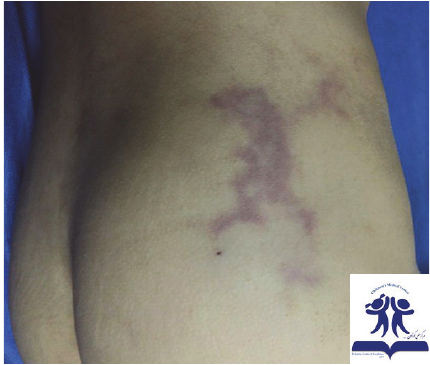
Figure 3: A 2.5-year-old boy with Nicolau syndrome after injection ofbenzathinepenicillin.Ecchymosisinthesiteofinjectionwithpain and coldness in the distal of